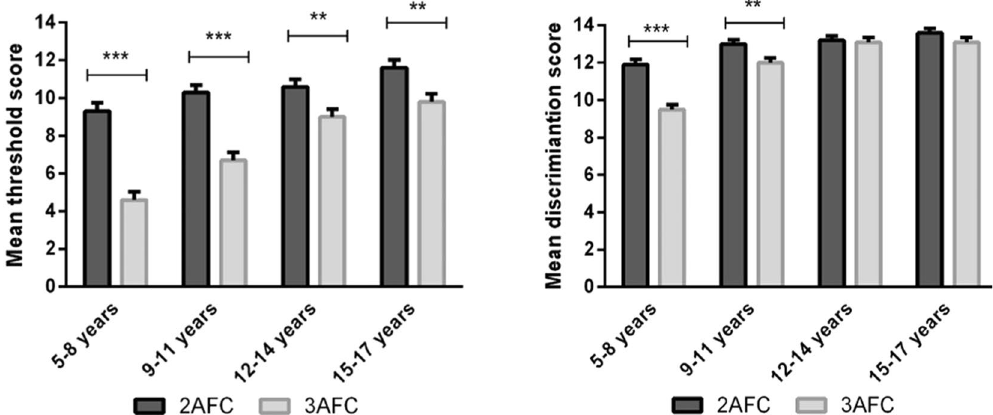
Figure 1. Olfactory threshold (1 a ) and odor discrimination (1 b ): mean scores separately for the 2AFC version and the 3AFC task across age groups. Error-bars indicated standard errors of means, * p < 0.05, ** p < 0.01, *** p < 0.001. For detailed results see Table 1.